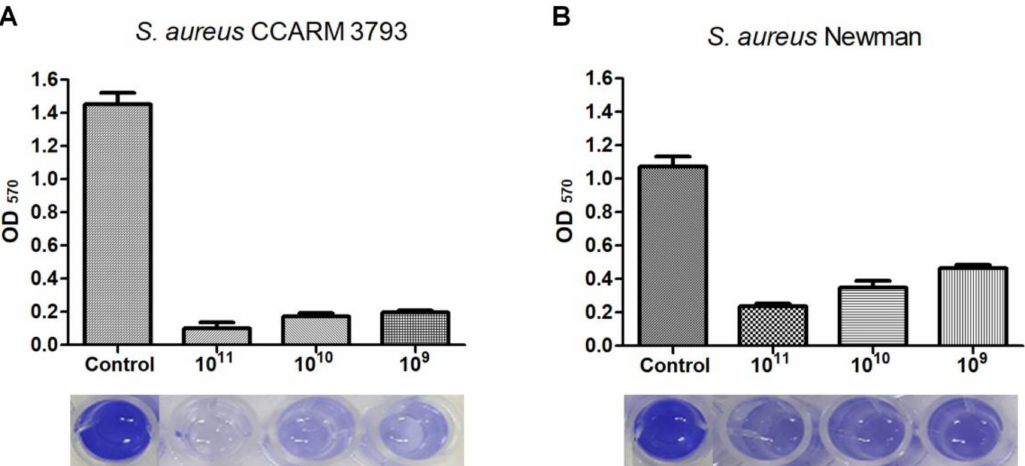
Figure 3. Removal of 24 h-old biofilm grown on a 96-well polystyrene microplate with phage CSA13. Biofilms of S. aureus CCARM 3793 ( A ) and Newman ( B ) were treated with three different PFUs of CSA13 for 24 h. Each column represents the mean of triplicate experiments, and error bars indicate the standard